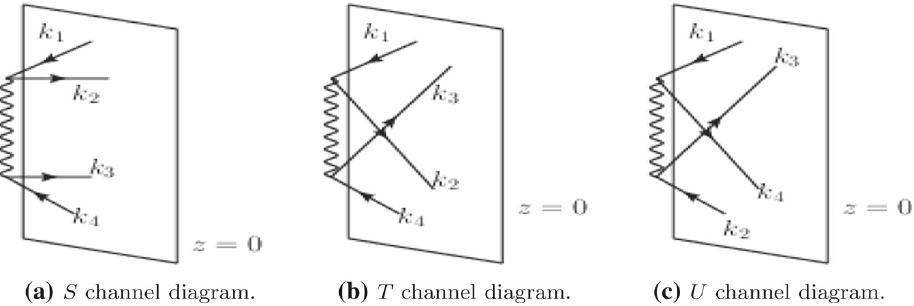
Fig. 17 Representative S , T and U channel diagram for bulk interpretation of four point scalar correlation function in the presence of graviton exchange contribution. In all the diagrams the graviton is propagating on the bulk and the end points of the scalars are attached to the boundary at z =